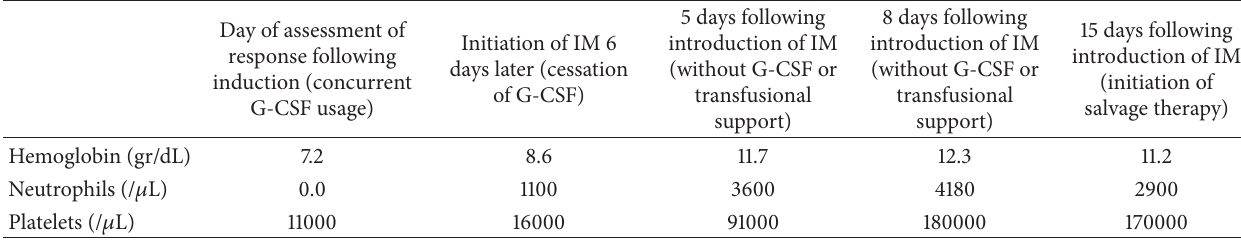
Table 1: Hematological response of our patient to imatinib mesylate